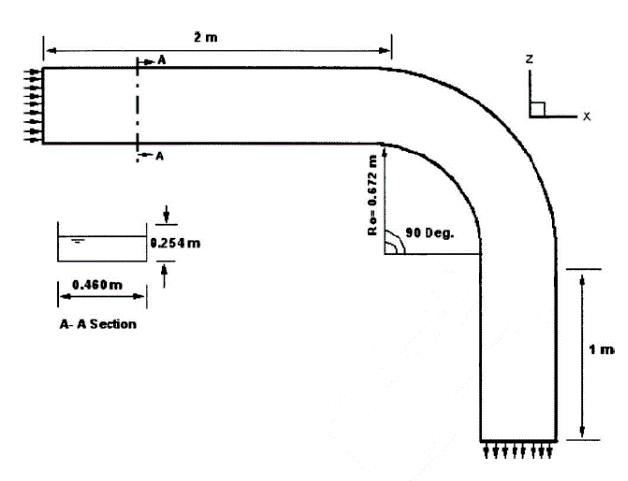
Figure 14. Geometric parameters and characteristics of 90 ◦ bend channel used in Matsuura 2004 [73] study (Reproduced from Khosronejad et al. (2007) [20] with permission from ASCE). A significant helical flow was noticed in this area as well. This helical flow caused transverse sediment transport directed towards the inner bank of the bend. It is reported that the transverse sediment transport is the main cause of the degradation occurring near the outer banks and aggradation occurring near the inner banks of alluvial channel bends (Dietrich and Whiting 1989) [74]. The comparison between the simulated and measured bed topography showed that the low-Reynolds k- ω model fits the bed changes data better than the standard k- ε model. The mean error was also calculated. The results show that the mean absolute difference (M.A.D.) of the predicted from the observed bed levels was significant at 0.05 level of risk ( α < 0.05) for the k- ω model (6.6 mm) and the k- ε model (8.2 mm). Additionally, the M.A.D. of the maximum observed scour depth of the k- ω and k- ε models was 11 and 13% and the standard deviations of absolute differences were 4.6